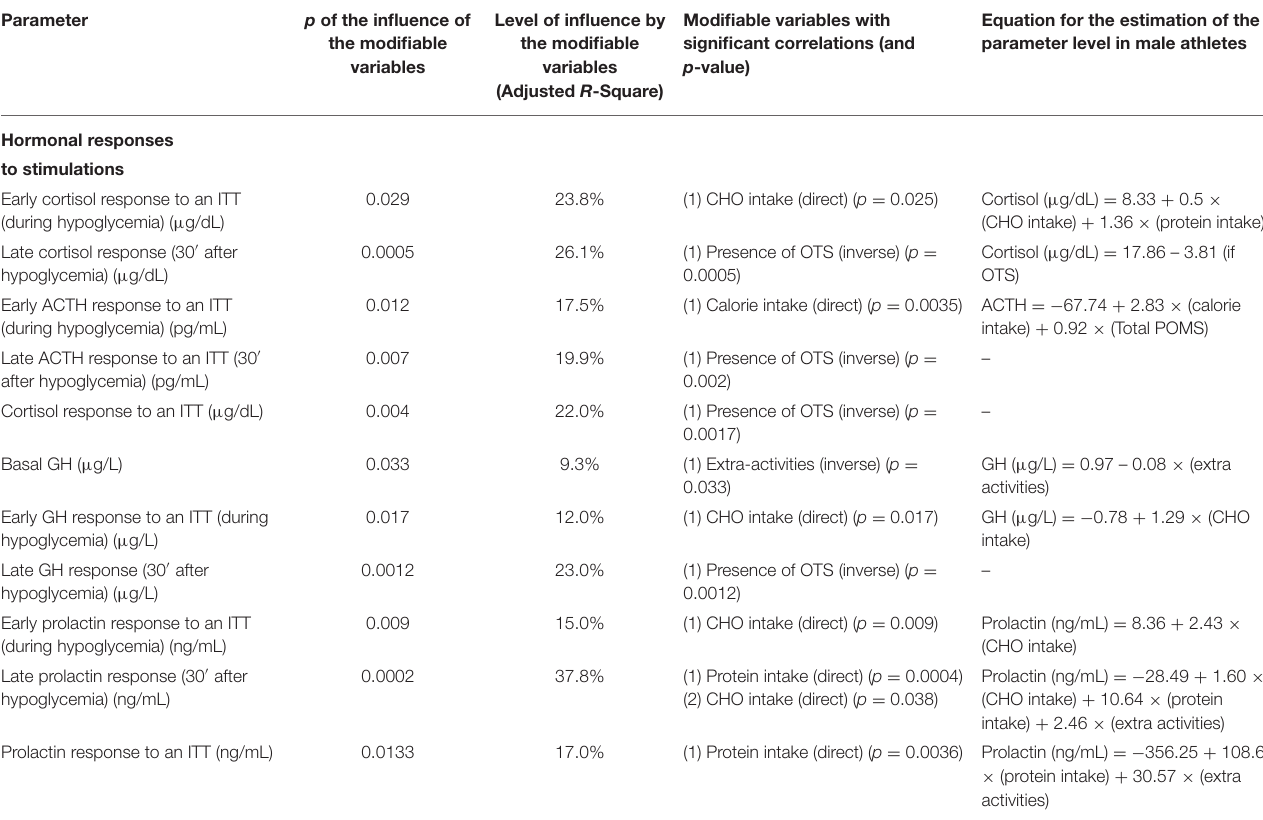
Parameter p of the influence of